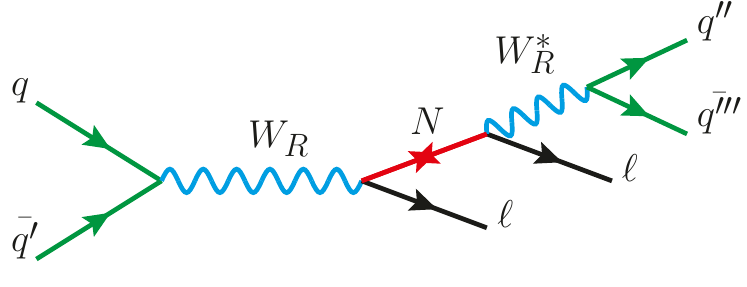
boson. R and m , respectively) up to several WR N